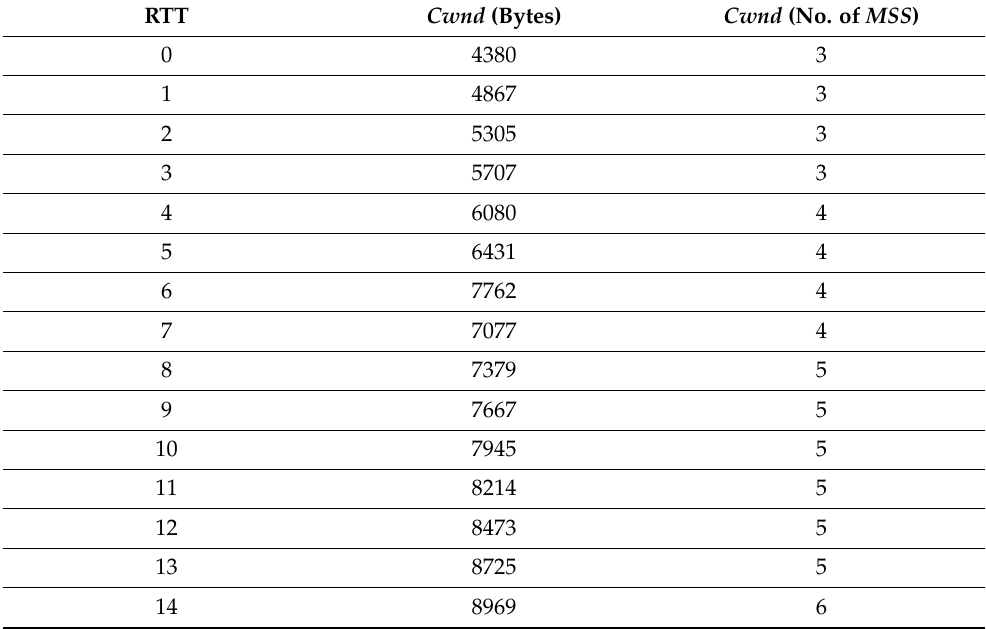
Table 9. Cwnd increased per